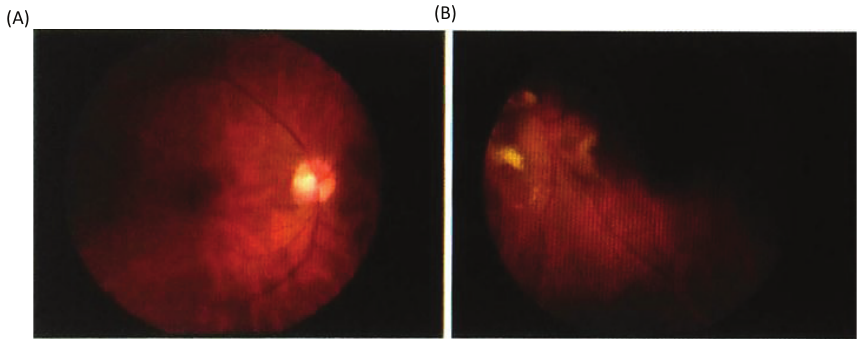
Figure 3. Optic fundi before radiosurgery. (A) Left healthy side. (B) Right lesion